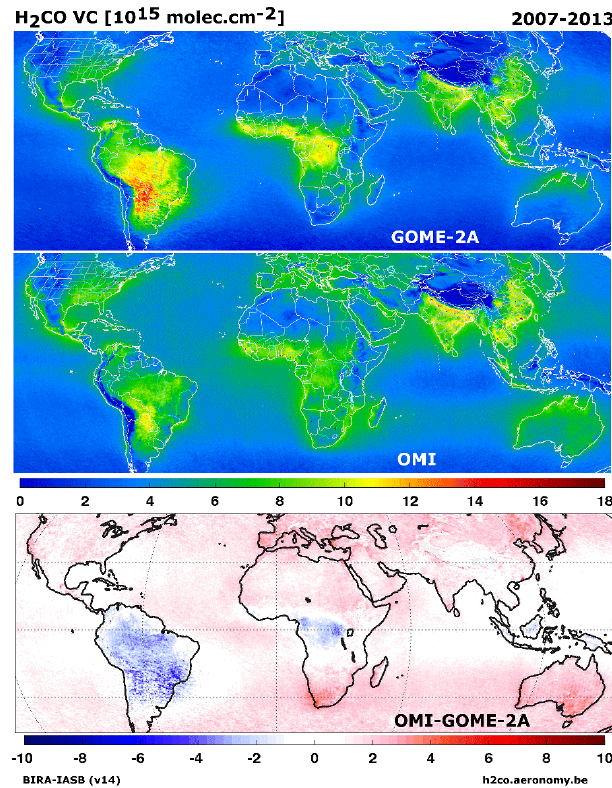
Figure 8. H 2 CO vertical columns retrieved from GOME-2/MetOp- A (first panel, EUMETSAT level-1 data), OMI/Aura (second panel, NASA level-1 data), and their absolute differences (third panel) be- tween 2007 and